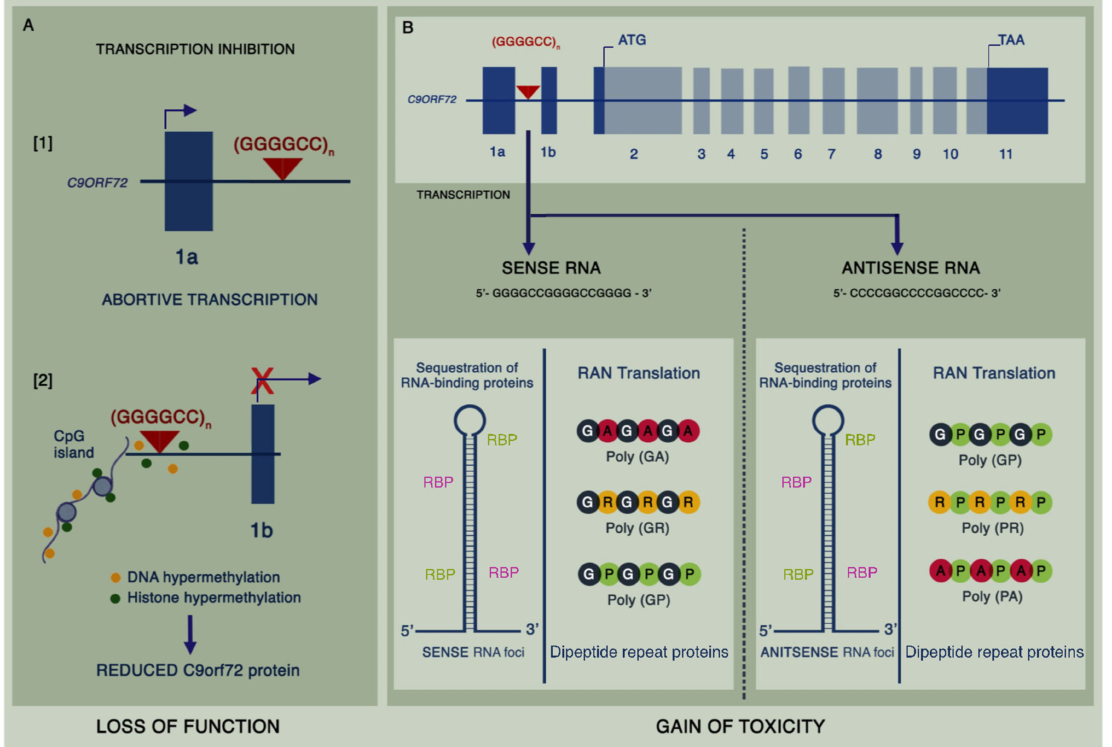
Figure 1. Pathological mechanisms associated with the hexanucleotide repeat expansion in C9ALS-FTD: ( A ) The presence of the expanded GGGGCC mutation in intron 1 of C9orf72 potentially causes abortive transcription from exon 1a leading to haploinsufficiency of C9orf72 protein (1). Loss of function is further compounded by reduced transcription secondary to hypermethylation of both DNA and histones (2). ( B ) Bidirectionally transcribed repeat RNA is proposed to be toxic by sequestering RNA-binding proteins into RNA foci, and through the formation of aberrant dipeptide repeat proteins arising from repeat-associated non-AUG-dependent (RAN)